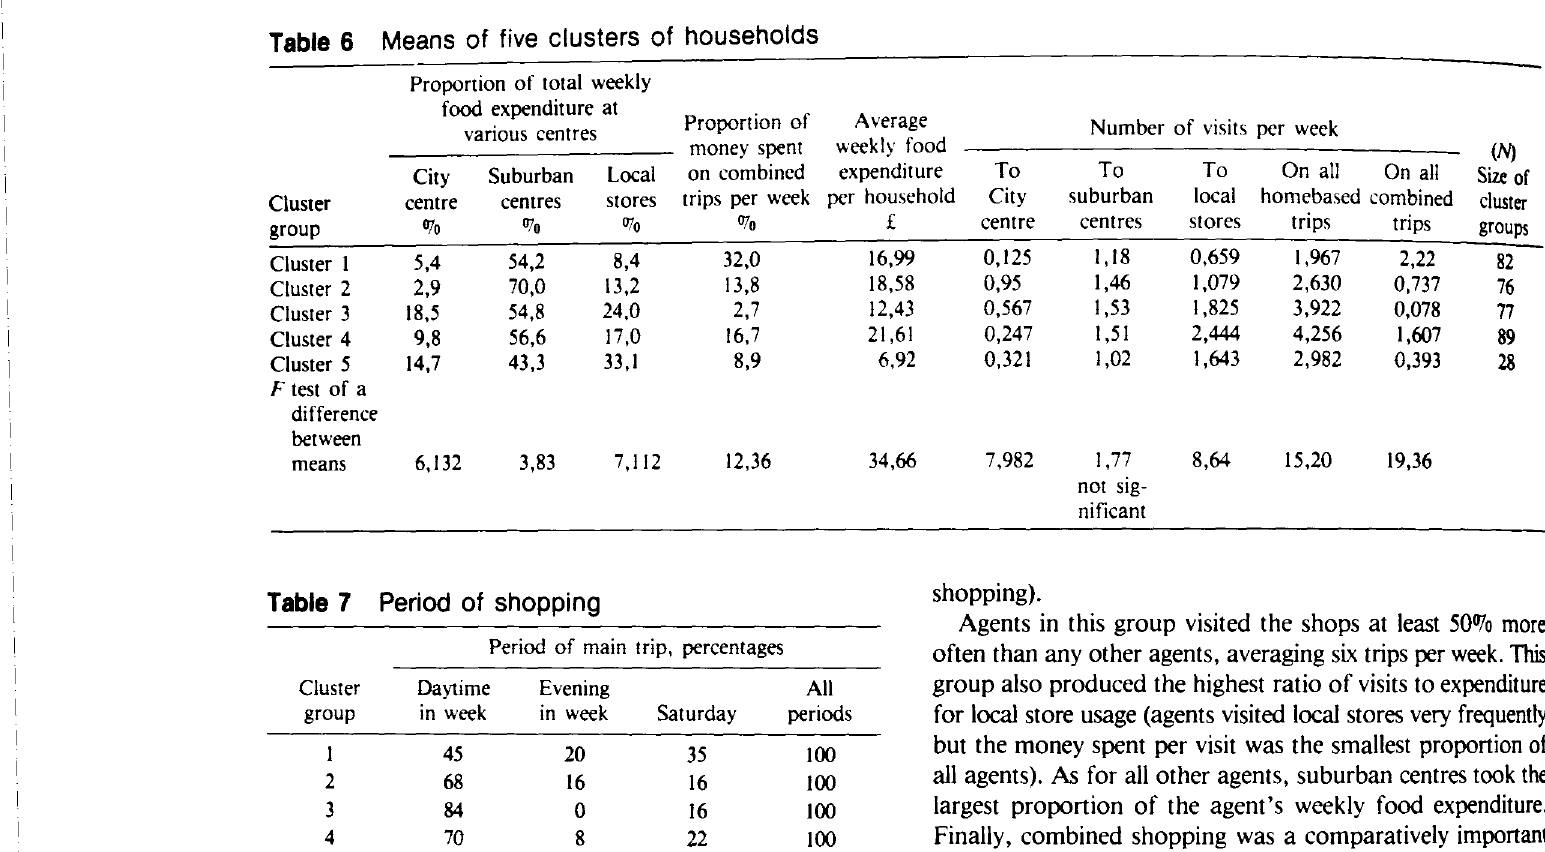
Means of five clusters of households